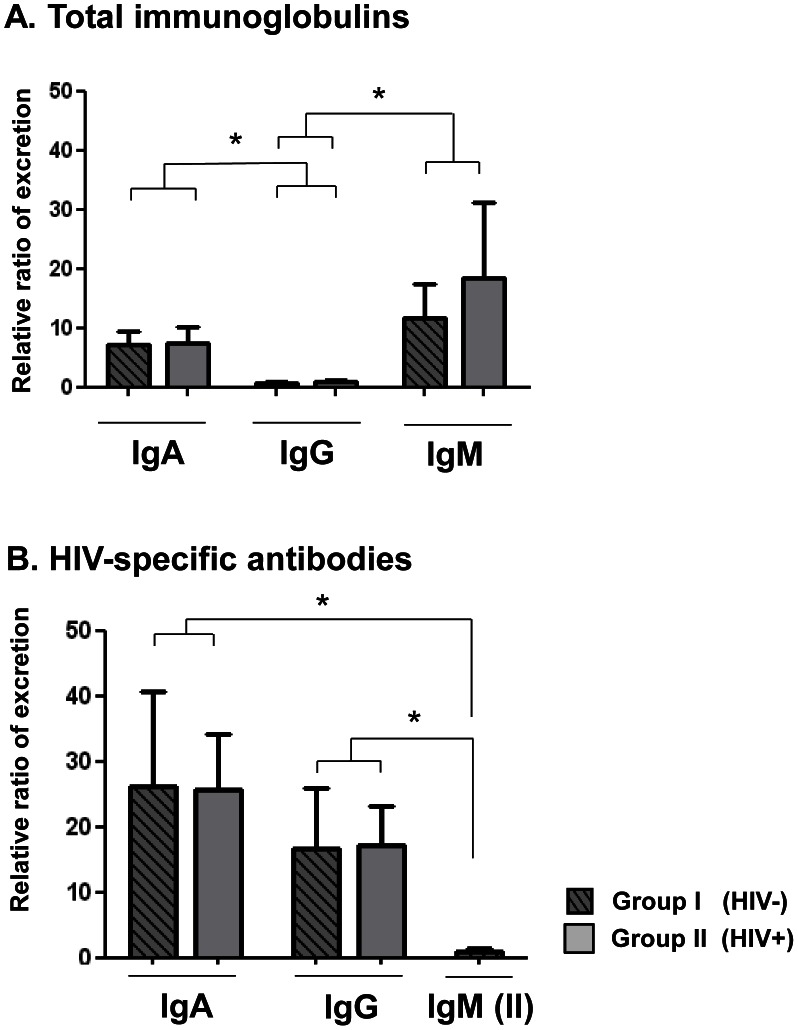
Relative ratios of excretion (RRE) by reference to lactoferrin of total IgA, IgG and IgM (A) and anti-gp160 antibodies of the IgA, IgG and IgM classes (B) in stool samples from8 HIV-1-infected mothers and their breast milk exposed non HIV-infected babies (group I) (grey bars) and from 6 couples of HIV-1-infected mothers and their breastfed HIV-1-infected babies (group II) (hatched grey bars).RRE is expressed as mean±standard error. The stars indicate the significant differences between the mean RRE of IgA, IgG and IgM, and those of HIV-specific IgA, IgG and IgM in the whole 14 study babies breastfed by their HIV-infected mothers (groups I and II) (* P<0.01).